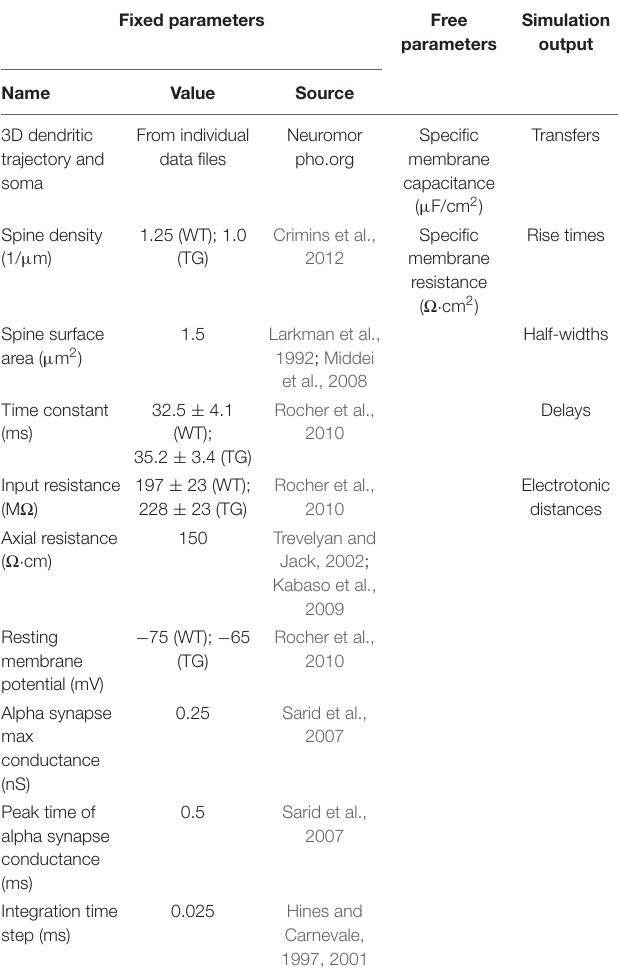
TABLE 1 | Summary of fixed morphological and physiological data used as input parameters of the model and free parameters computed by fitting procedures, as well as a set of simulation output